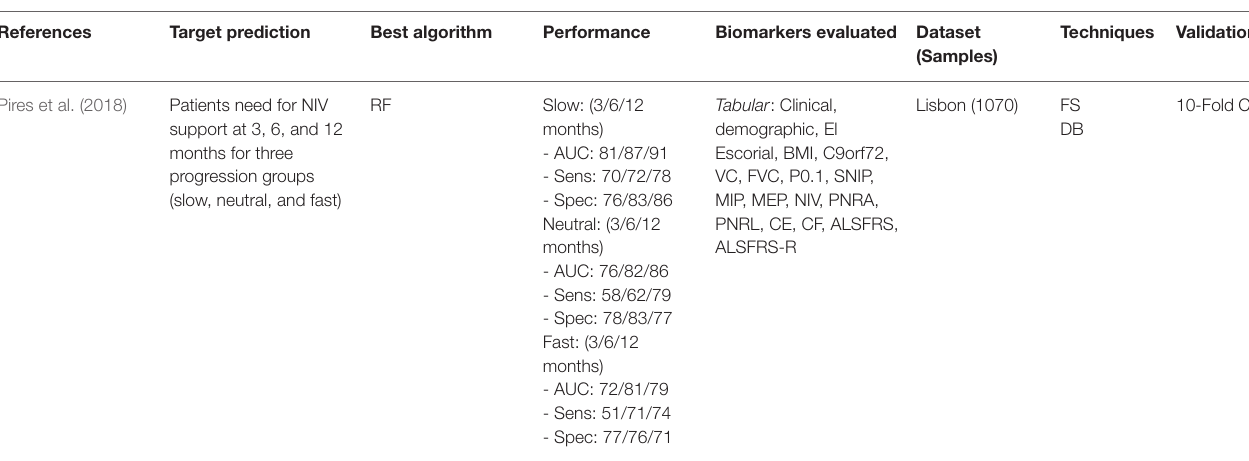
TABLE 8 | Overview of ML approach on need for support.